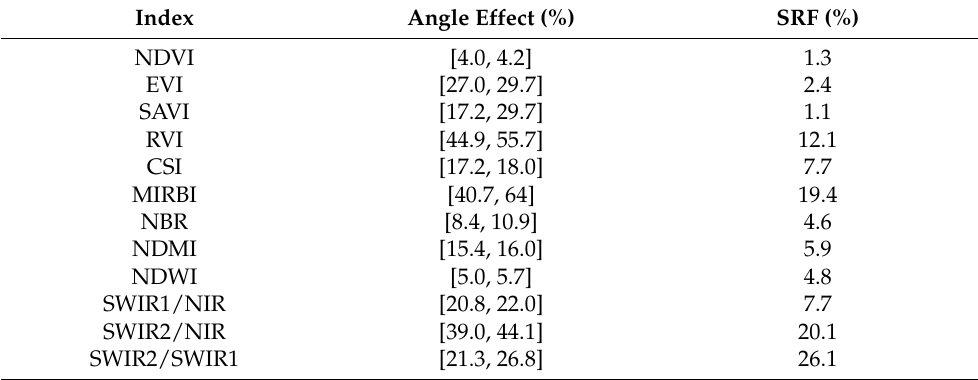
Table 6. Comparison of angle effect and spectral response function (SRF) effect relative error on each discussed index calculated from the simulated value in the principal plane (PP) on 17